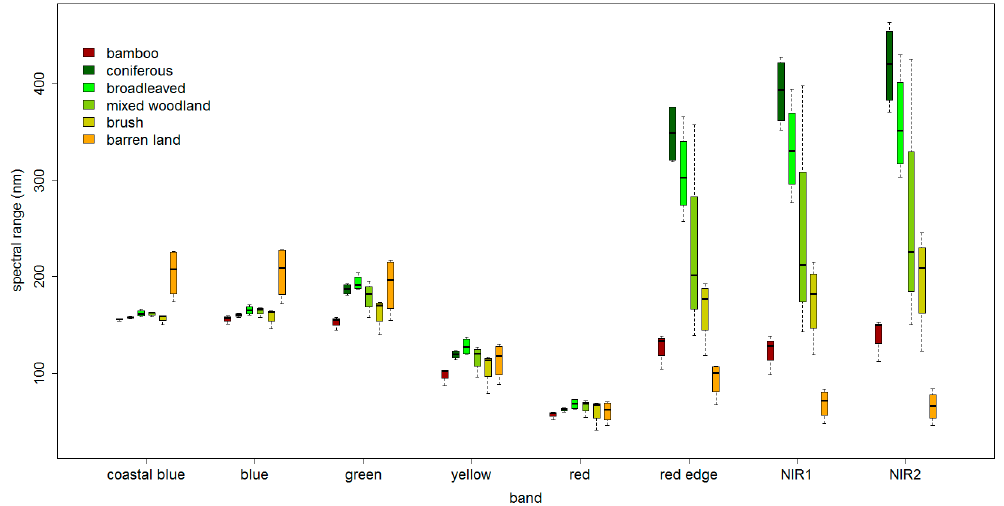
Figure 3. Distributions of the reflectance of different land cover types across eight MS bands.